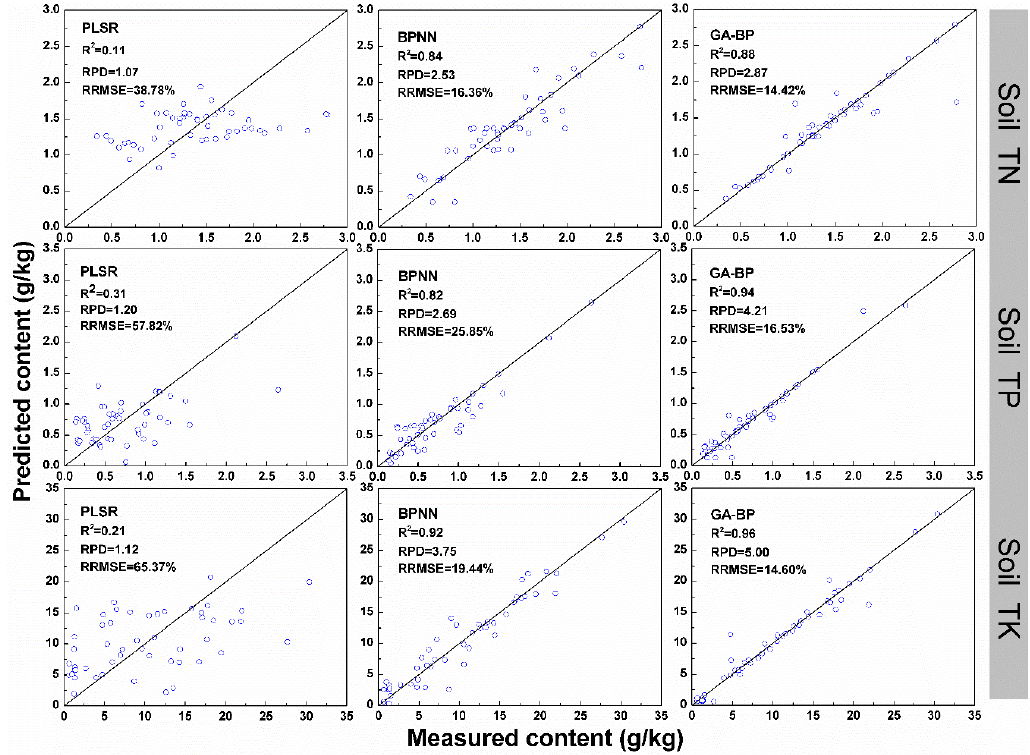
Figure 7. Scatterplots of measured versus predicted values of the soil nutrient contents obtained by partial least squares regression (PLSR), BPNN and GA-BPNN (R 2 : coefficient of determination; RRMSE: relative root mean square error; RPD: ratio of performance to deviation).